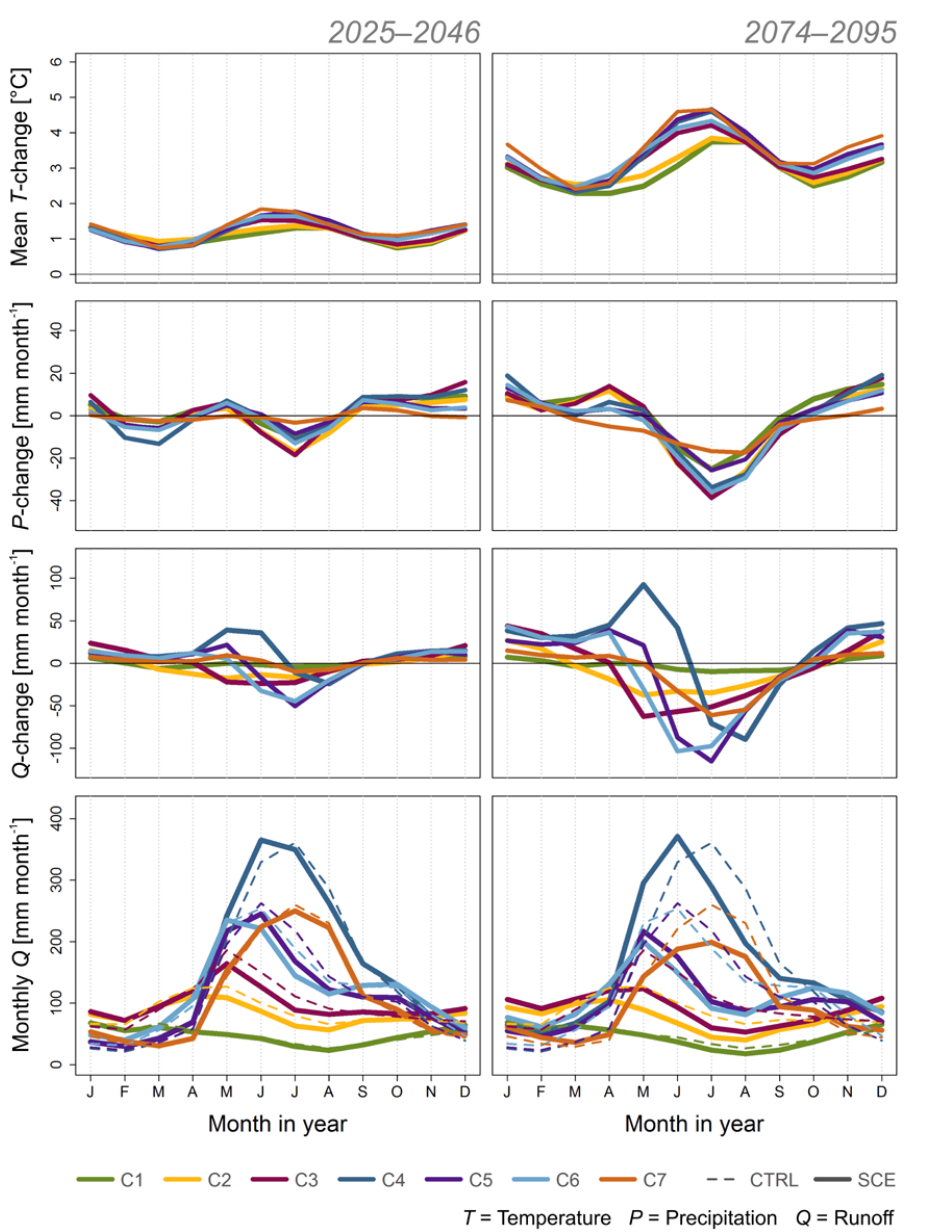
Fig. 5. Hydro-climatological change signals per cluster (absolute temperature, precipitation and runoff change, rows 1 to 3 from top), relative runoff change (4th row) and absolute monthly runoff (bottom row) for the control period (CTRL, dashed lines), the near future period (SCE, solid lines in left column) and the far future period (SCE, solid lines in right column). The change signals are given as absolute values to facilitate direct comparison with the absolute monthly